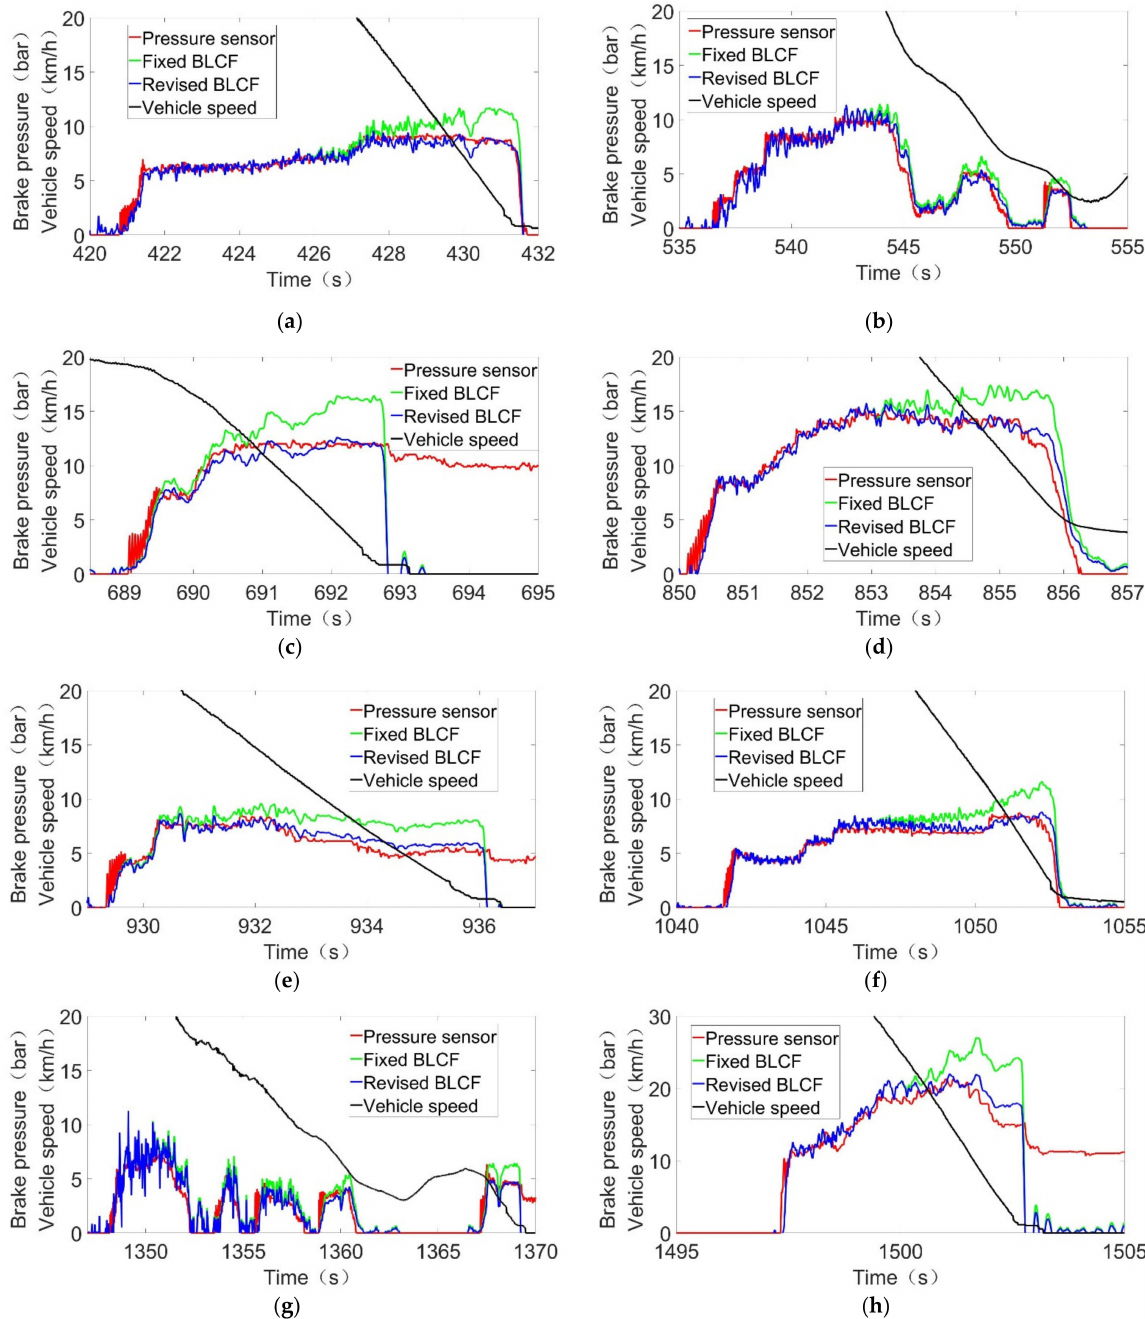
Figure 13. Test results of master cylinder pressure estimation (MCPE): ( a – h ) represent different brake